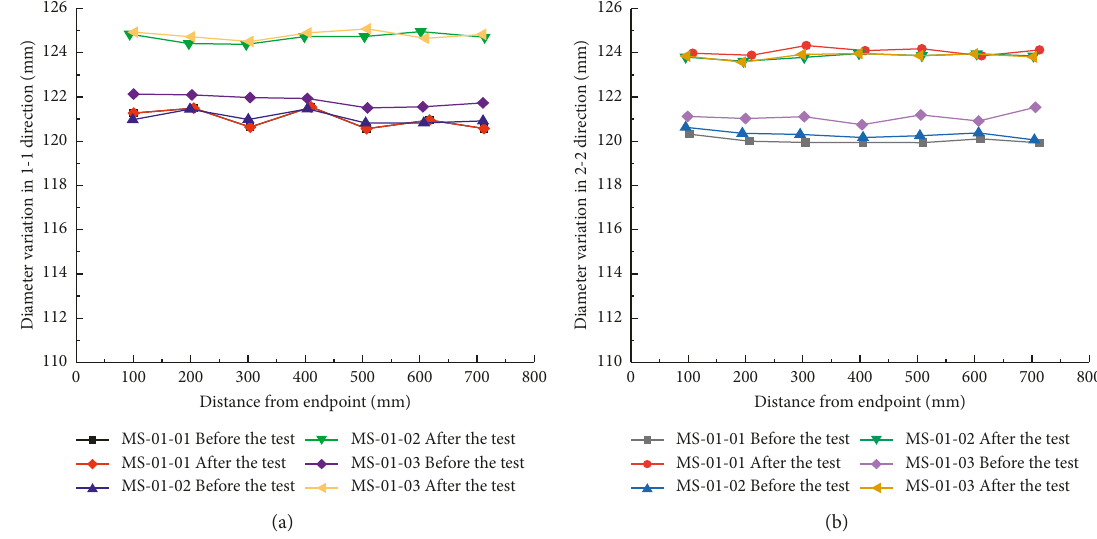
Figure 6: Diameter variation of constant resistance casing before and after the test: (a) diameter variation of 1-1 section; (b) diameter variation of 2-2 section.